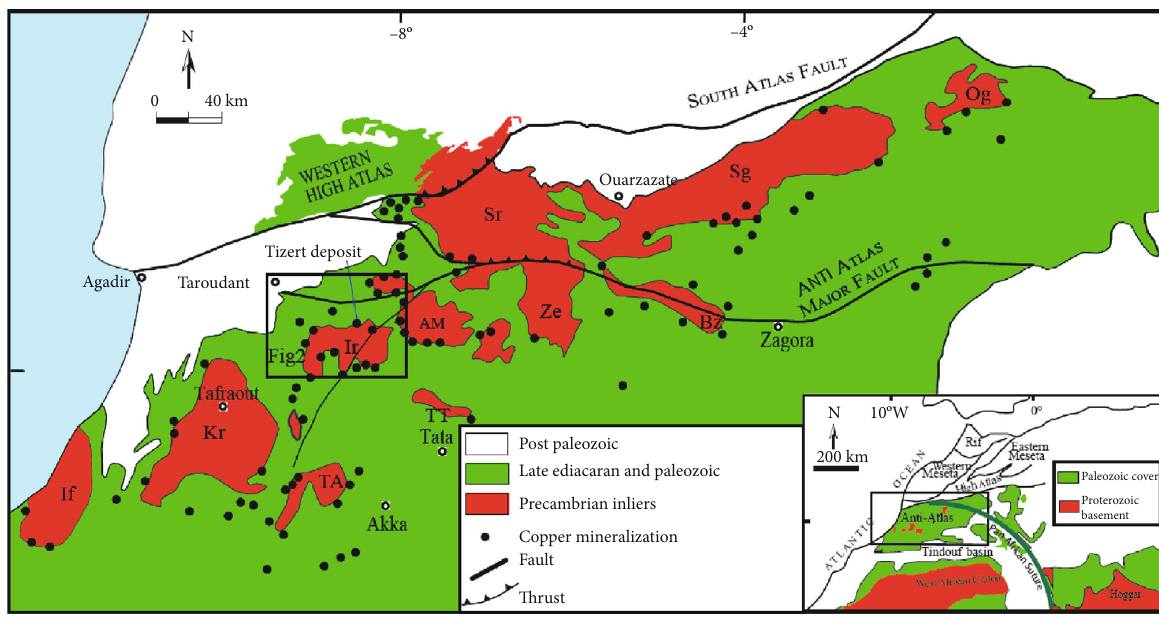
Figure 1: Copper mineral occurrences of the Anti-Atlas Copperbelt (modi fi ed from Bouchta et al., 1977). Inlier abbreviations: If: Ifni; Kr: Kerdous; Ir: Igherm; TA: Tagragra d ’ Akka; TT: Tagragra Tata; AM: Agadir Melloul; Ze: Zenaga; Sr: Sirwa; Bz: Bou Azzer-El Graara; Sg: Saghro; Og: Ougnate. Inset: location of the Anti-Atlas within the structural domains of NW